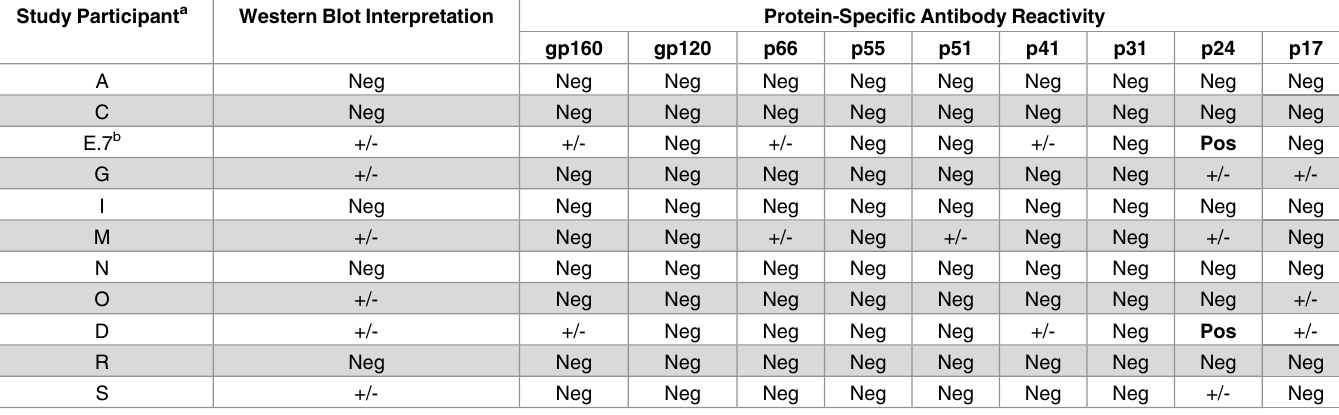
Table 2. HIV-specific antibody responses of plasma